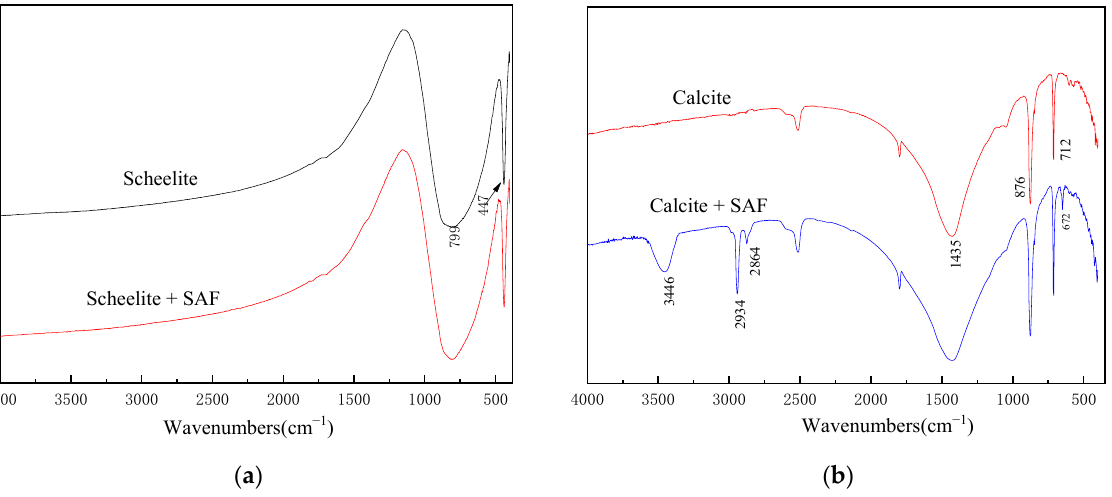
Figure 9. FTIR spectra of ( a ) scheelite and ( b ) calcite treated with and without SAF at pH